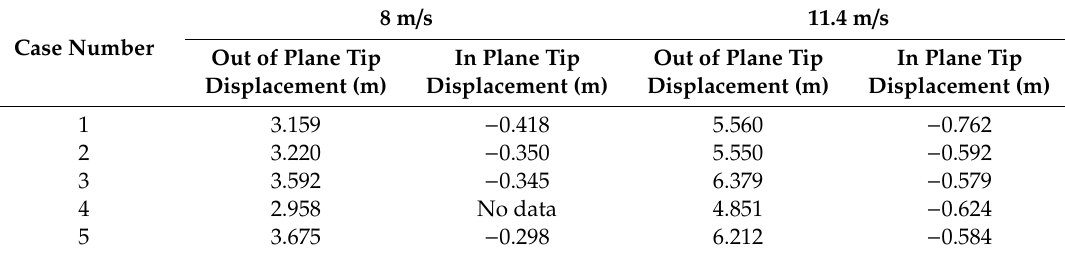
Table 8. Comparison of tip deflection with different research.